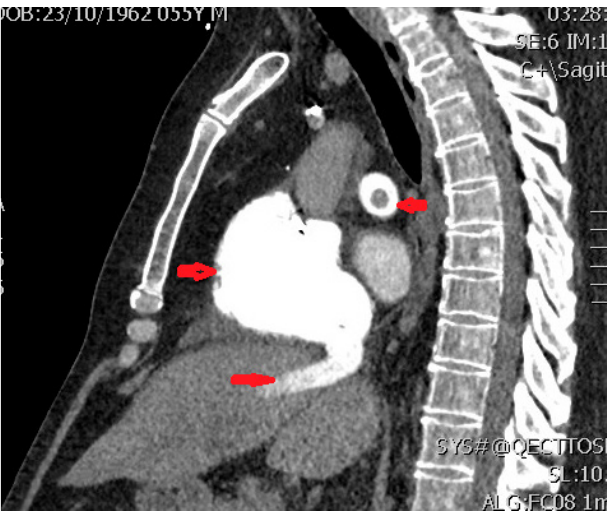
Fig. 2 - Computed tomography of pulmonary artery (sagittal view). Arrows show right ventricular dilatation with reverse flow in inferior vena cava and clot in the pulmonary